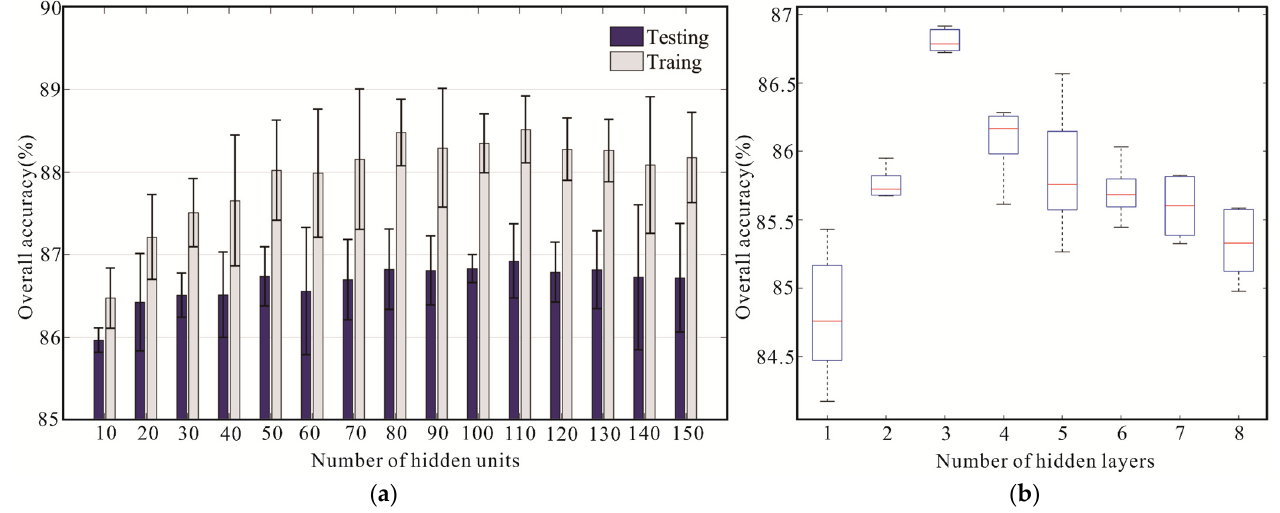
Figure 6. ( a ) The OA obtained from framework with different hidden units. ( b ) The OA results from framework with a different number of hidden layers.